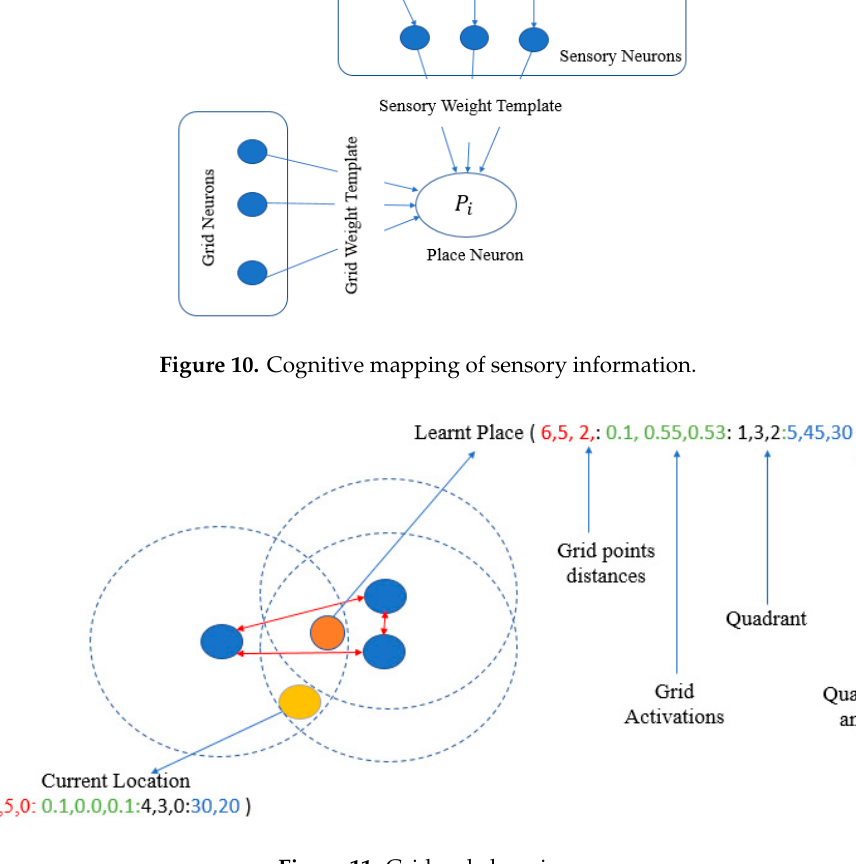
Figure 11. Grid code learning.